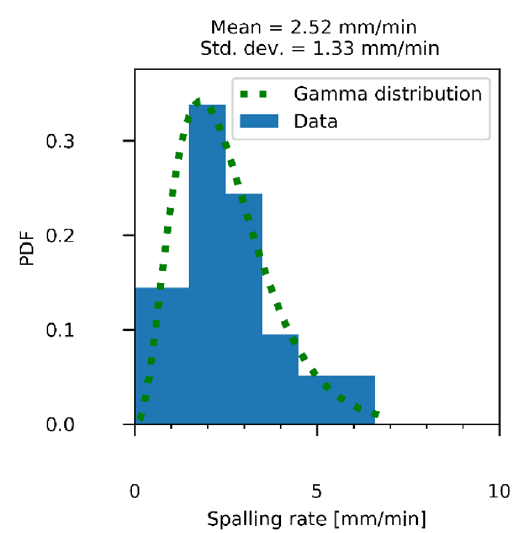
Figure 3. Spalling rate data listed by Hua et al. (2021) and fitted Gamma distribution.